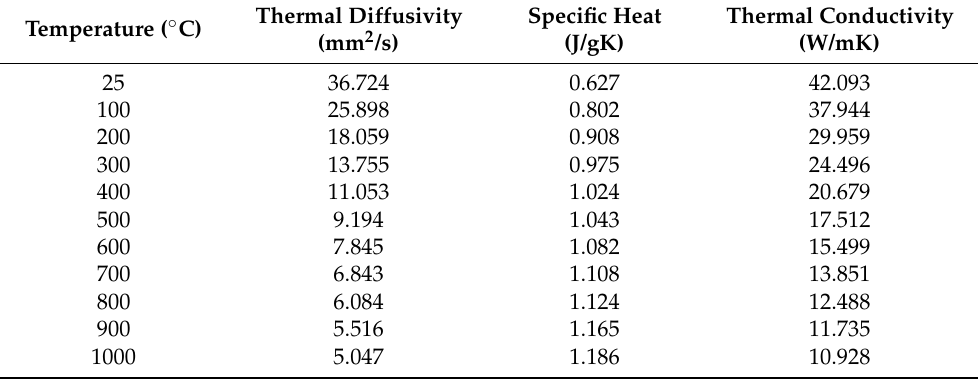
Table 9. Thermophysical properties of the aged samples obtained from slabs 17 and 18. Average values of the two samples.